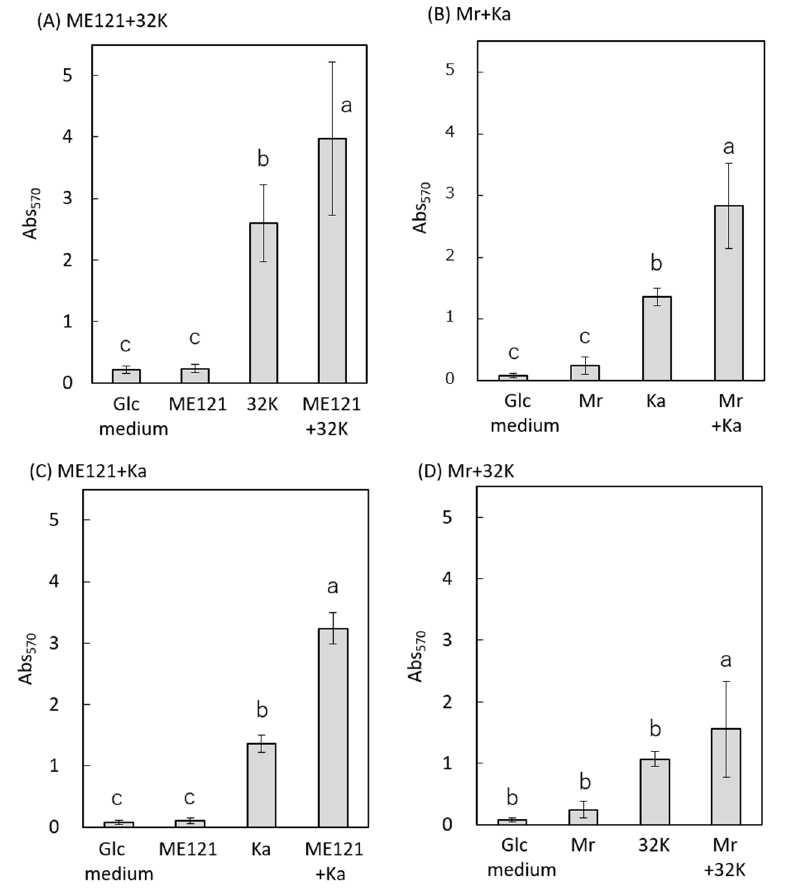
Figure 5. Biofilm formation during coculture of di ff erent combinations of bacterial strains. ( A ) Coculture of strains ME121 and 32K, ( B ) coculture of M. radiotolerans (Mr) and K. adipata (Ka), ( C ) coculture of strain ME121 and K. adipata (Ka), and ( D ) coculture of M. radiotolerans (Mr) and strain 32K. The vertical axis is Abs 570 , and the error bar is standard deviation. One-way ANOVA test was performed for equality of all means; ( A ): F (3, 19) = 98.90, p < 0.001. ( B ): F (3, 19) = 49.47, p < 0.001. ( C ): F (3, 19) = 389.05, p < 0.001. ( D ): F (3, 19) = 10.90, p < 0.001. Tukey’s test was performed for post hoc analysis, p < 0.05. Di ff erent superscript letters (a, b, c) denote significant di ff erence from each other in all combinations.